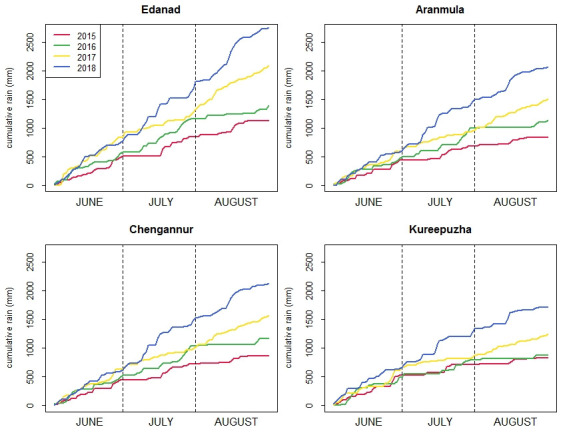
Cumulative rainfall for June July Aug. from 2015–2018.